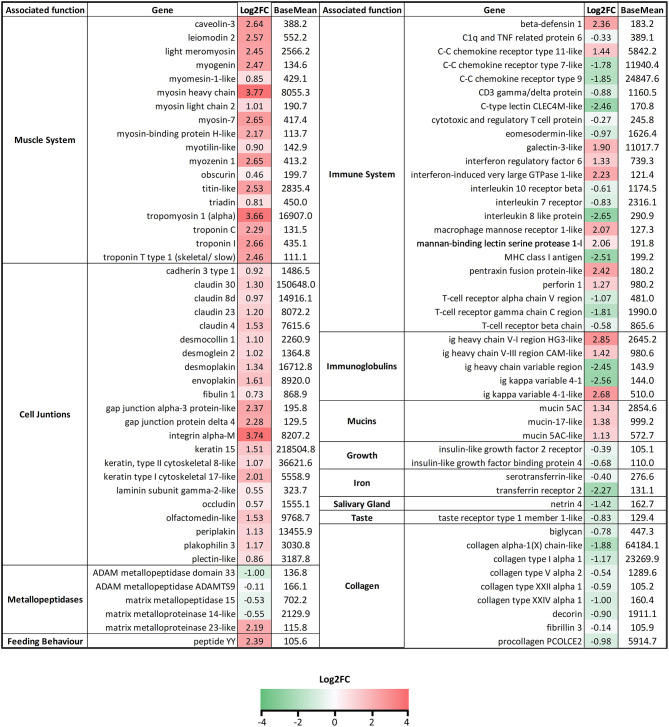
List of selected genes DE in tongue samples of Ceratothoa-infected Dicentrarchus labrax. The genes were grouped in categories regarding their associated function. The numbers represent the Log2 fold change values and the color scale corresponds to −4-0-4 (green-white-red) Log2FC. BaseMean values represent the average of normalized counts divided by the size factor, taken over all samples.